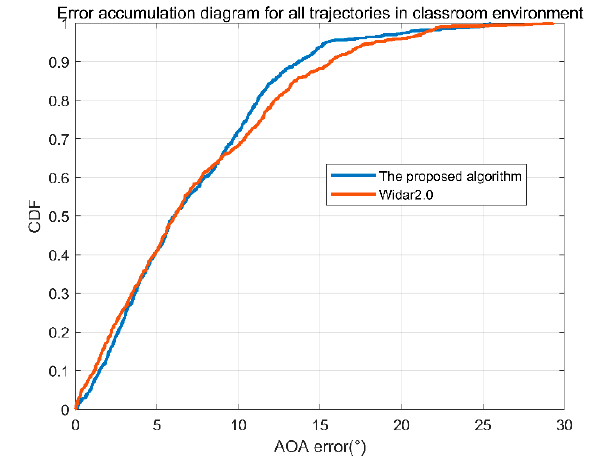
Figure 13. Cumulative angle error of the classroom.